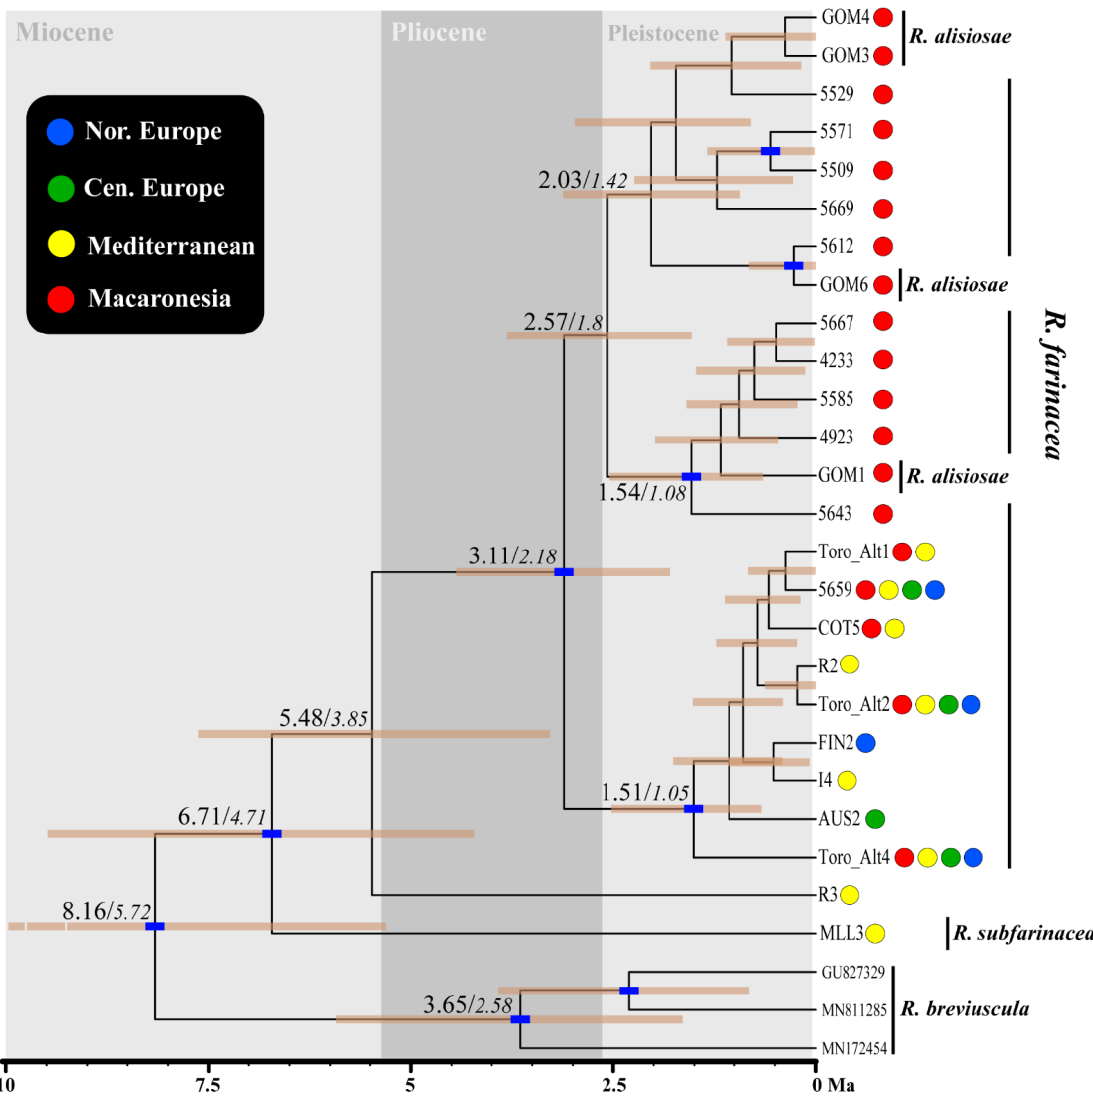
Figure 5. Chronogram calculated with BEAST that depicts divergence times for haplotypes of Ramalina farinacea and closely related species based on a concatenated nrITS + uid70 sequence dataset; the geographical distribution of haplotypes represented by each specimen at tips is indicated with a colored circle (see legend on the left margin); estimated ages on the left and right correspond with those inferred using an Oropogon [61] or a Melanohalea [62] nrITS substitution rate, respectively; nodal brownish bars show the 95% highest posterior density intervals (HPD) for selected nodes obtained in the analysis using the Oropogon rate; the blue rectangle indicates that posterior probabilities for these nodes were ≥ 0.95; MA: million years